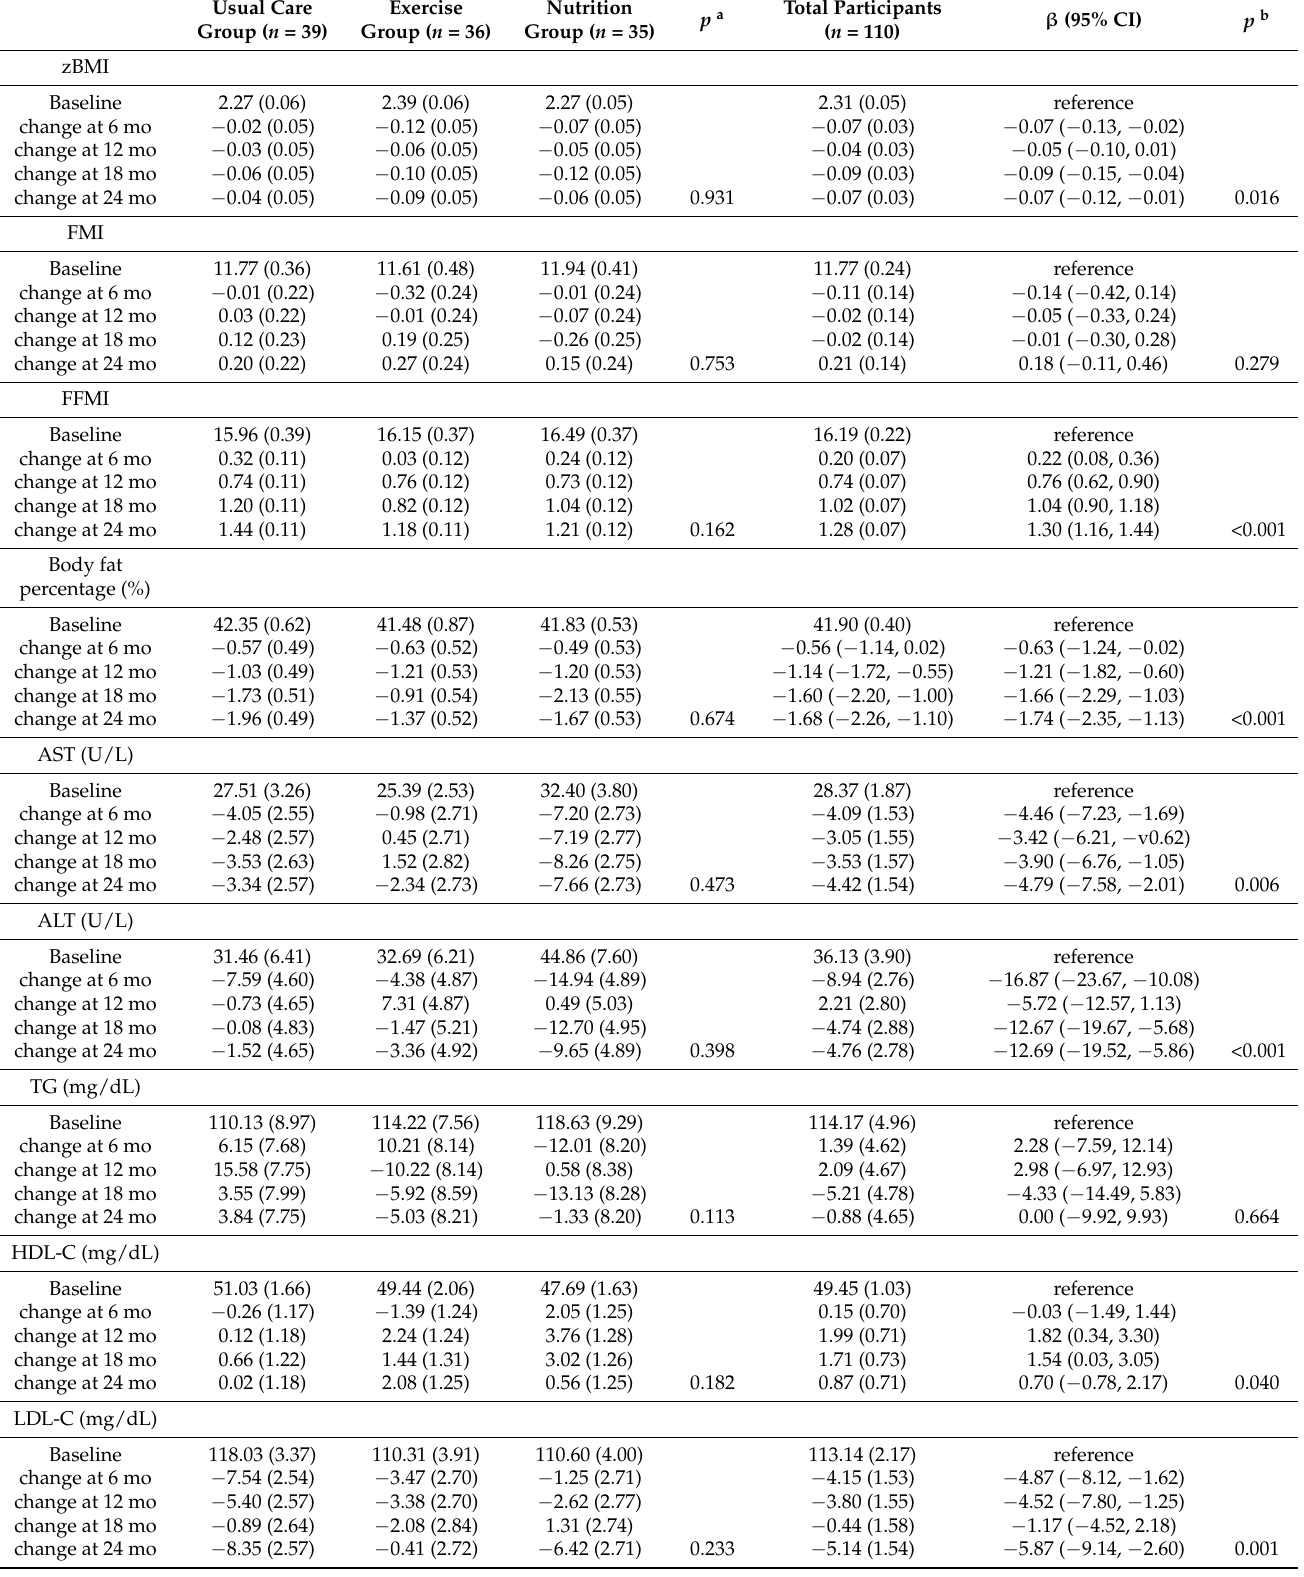
Table 2. Changes in secondary outcomes according to intervention groups and treatment